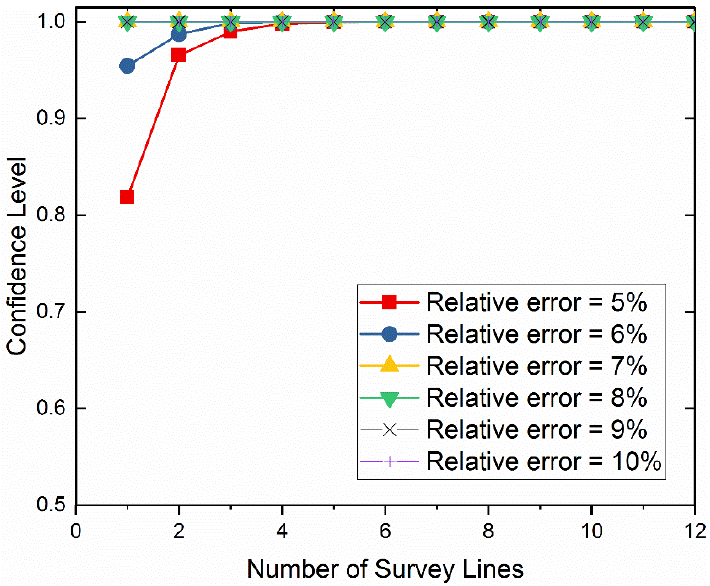
Figure 5. Relationship between the confidence level and number of survey lines under a given relative error ranging from 5% to 10% in a 60 m pixel.